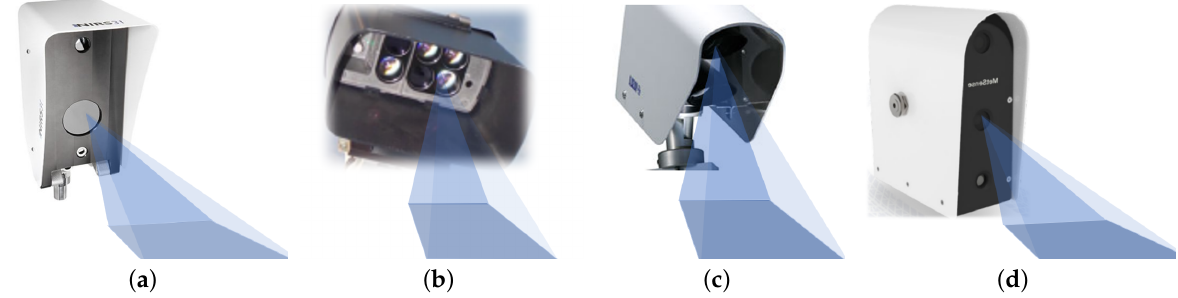
Figure 10. Typical, fixed products: ( a ) NIRS31-UMB remote sensing RSC sensor from LUFFT (Ger- many) [32], ( b ) StaRWIS-UMB remote sensing RSC sensor from LUFFT Germany) [33], ( c ) DSC111 road surface sensor from Vaisala (Finland) [34], and ( d ) 2DRoad from Metsense (Sweden)